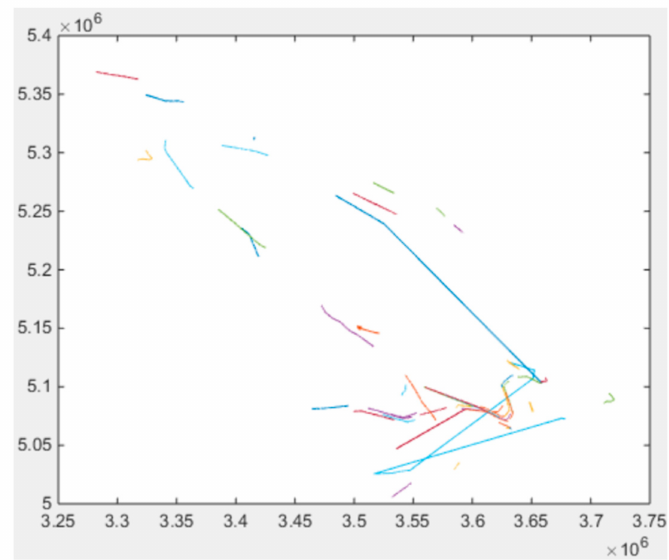
Figure 10. Spatial distribution of ship historical trajectories (50